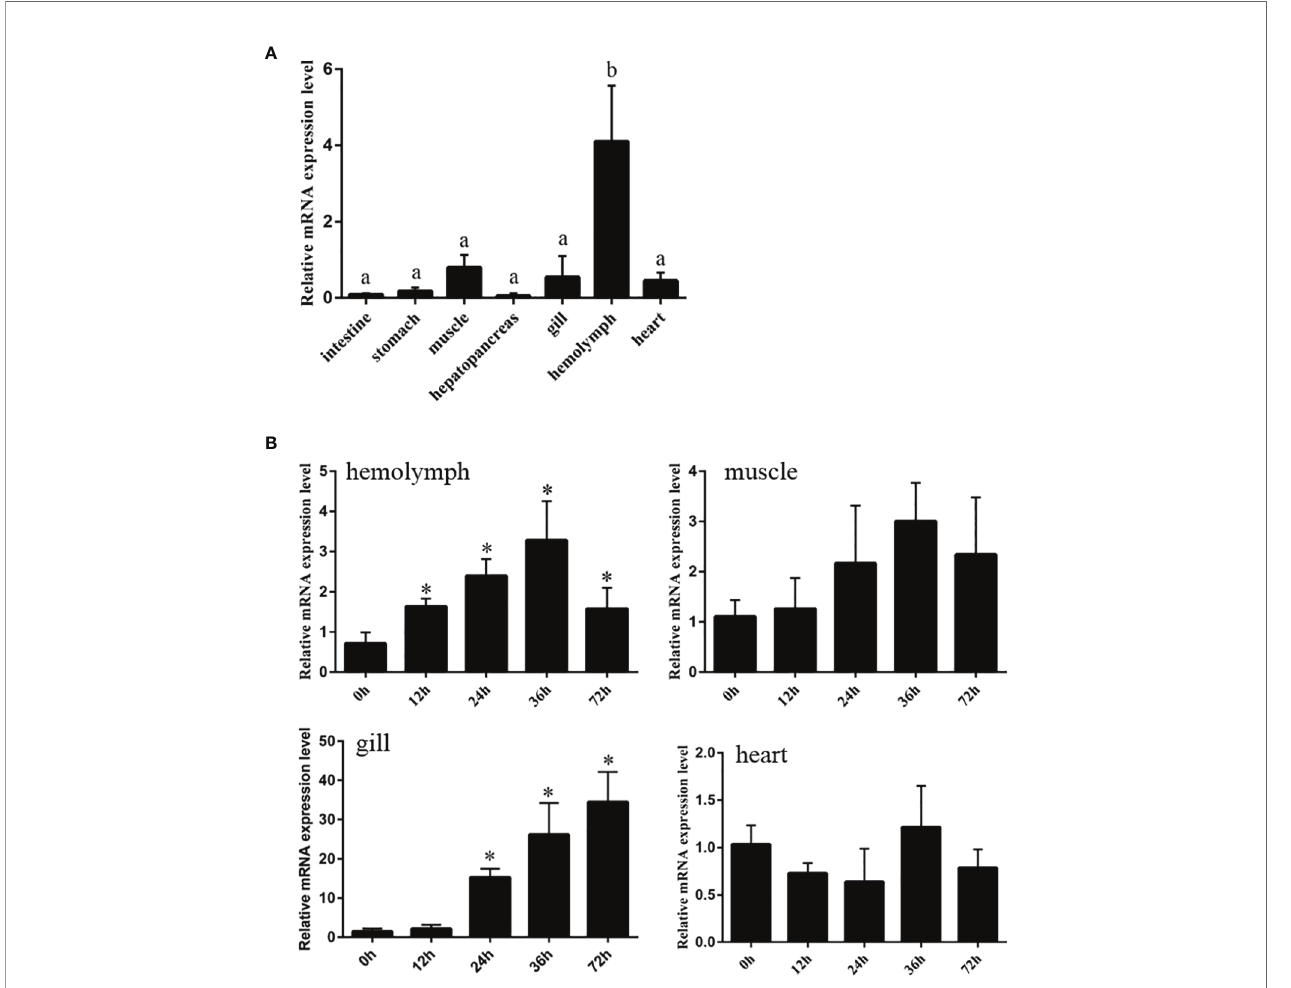
FIGURE 2 | Expression patterns of the Tatritin gene in healthy and infected Chinese horseshoe crab with A. hydrophila . (A) The expression of Tatritin was measured by qRT-PCR in seven tissues, intestine, stomach, muscle, hepatopancreas, gill, hemolymph, and heart from healthy horseshoe crabs. (B) The expression pattern of Tatritin in hemolymph, gill, muscle, and heart infected with A. hydrophila . Gapdh was used as the internal reference. Each experiment was executed in triplicate. Data are shown as mean ± SD (N = 3). The asterisk and different letters indicate signi fi cant difference (* p < 0.05) compared with the control (set as